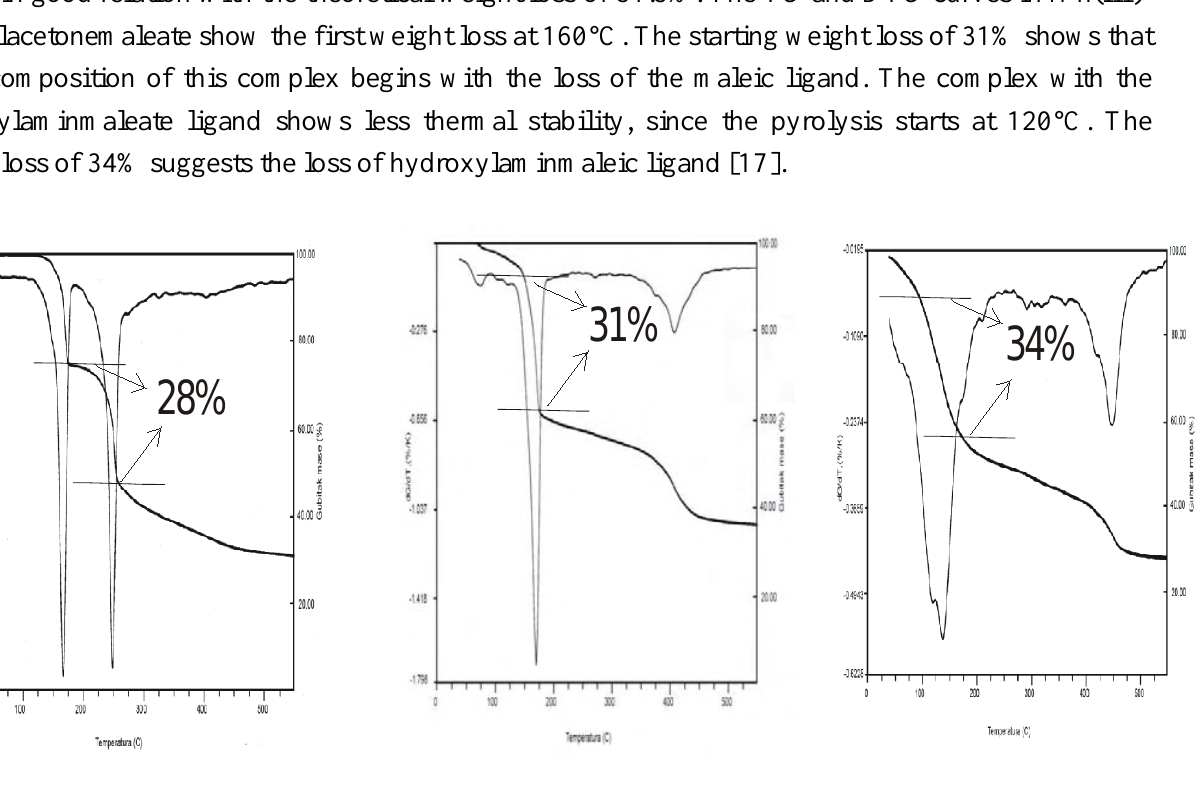
Figure 8. The TG and DTG curves a) of Mn(III)-acetylacetone, b) of Mn(III)-diacetylacetonemaleate and c) of